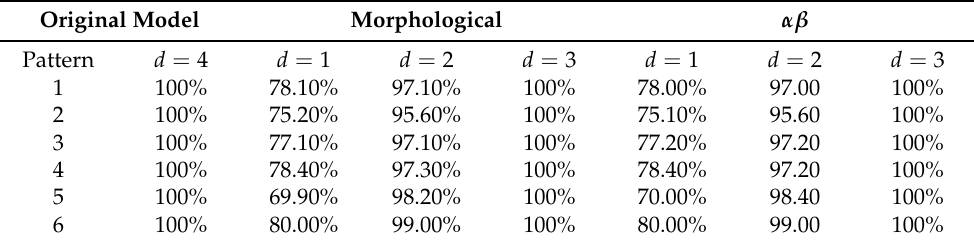
Table 7. Performance of the proposed model vs. original model in 80 × 80 binary images.